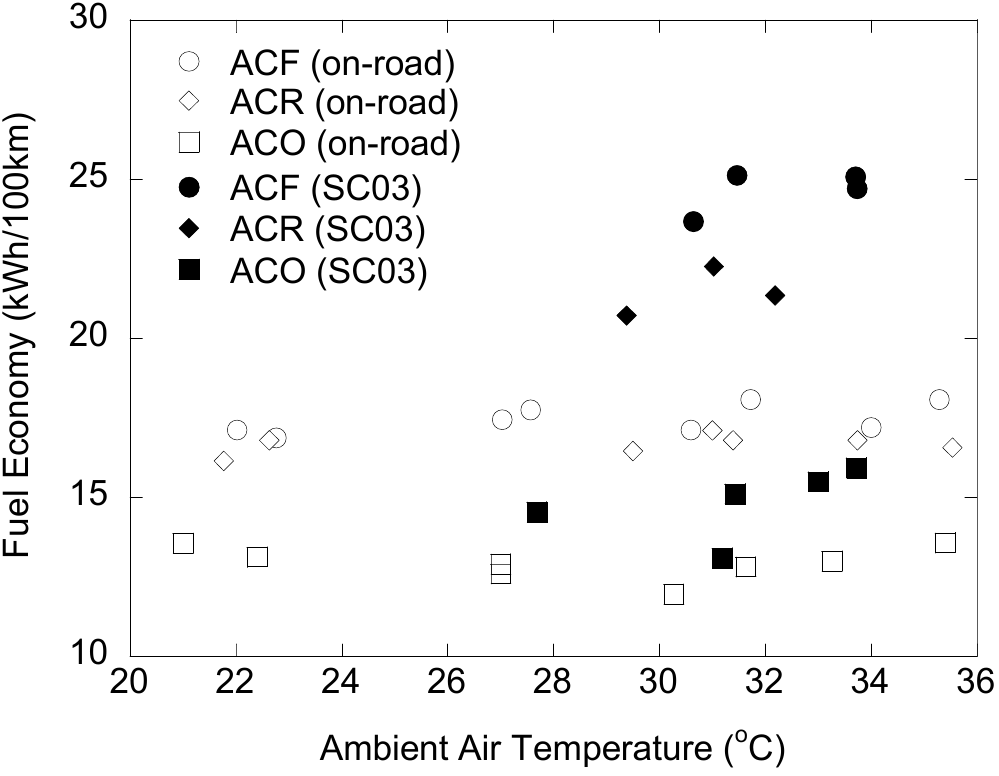
Figure 6. Fuel Economy calculated from the OBD-II data for all tests.